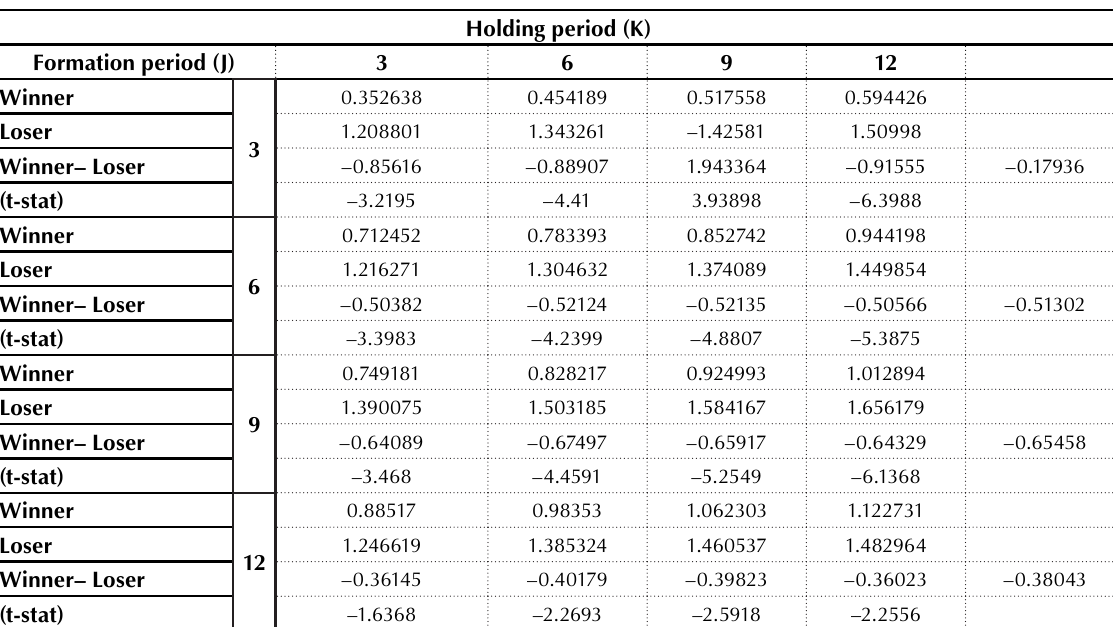
Table 3. Returns of trading vol (high trading volume) momentum